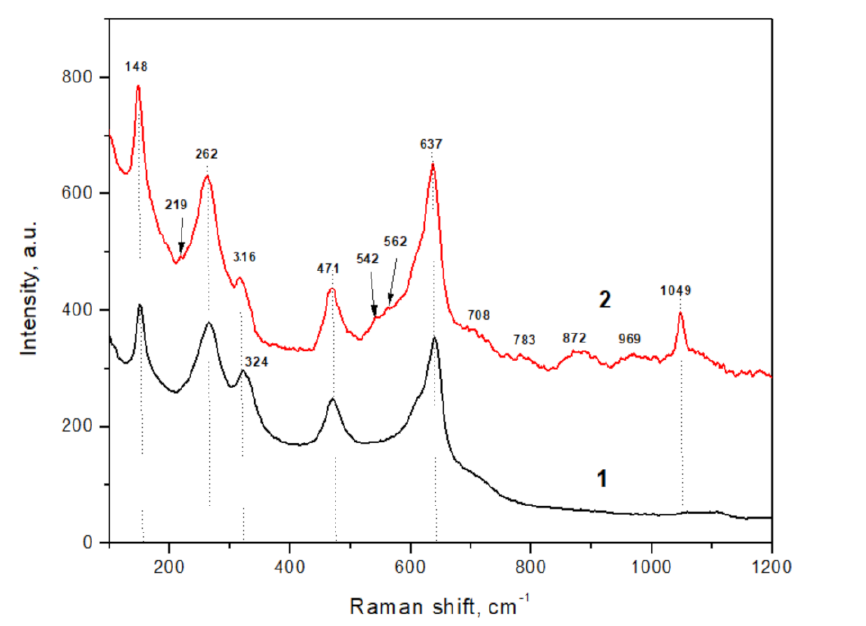
Figure 4. Raman spectra of dry (black line, 1) and deuterated (red line, 2) ZrO 2 + 3 mol% Y 2 O 3